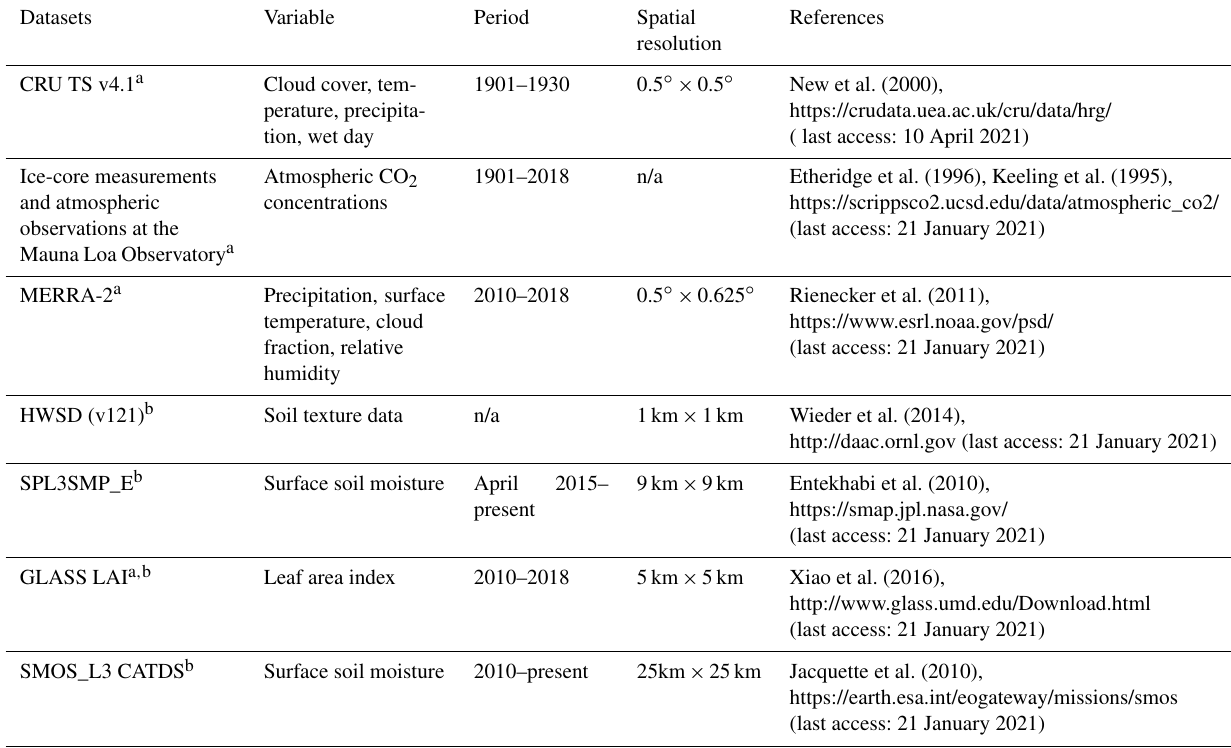
Table 2. List of the selected forcing and remote sensing datasets used in this study. Datasets